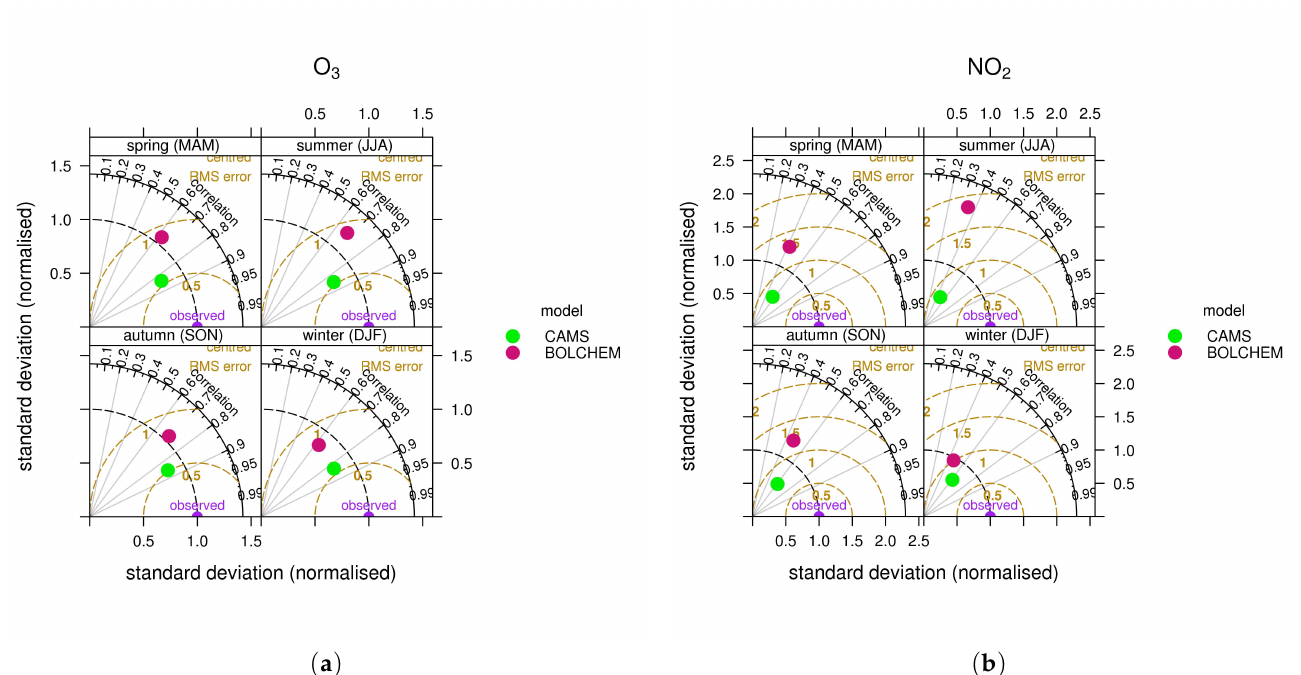
Figure 17. Taylor diagram generated for O 3 ( a ) and for NO 2 ( b ) for BOLCHEM and CAMS ensemble median (on sea- sonal